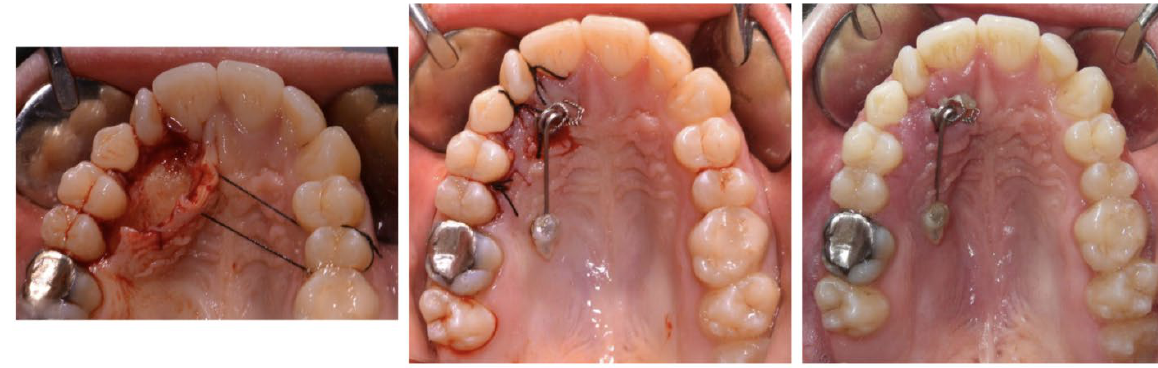
Figure 2. Direct anchorage group.